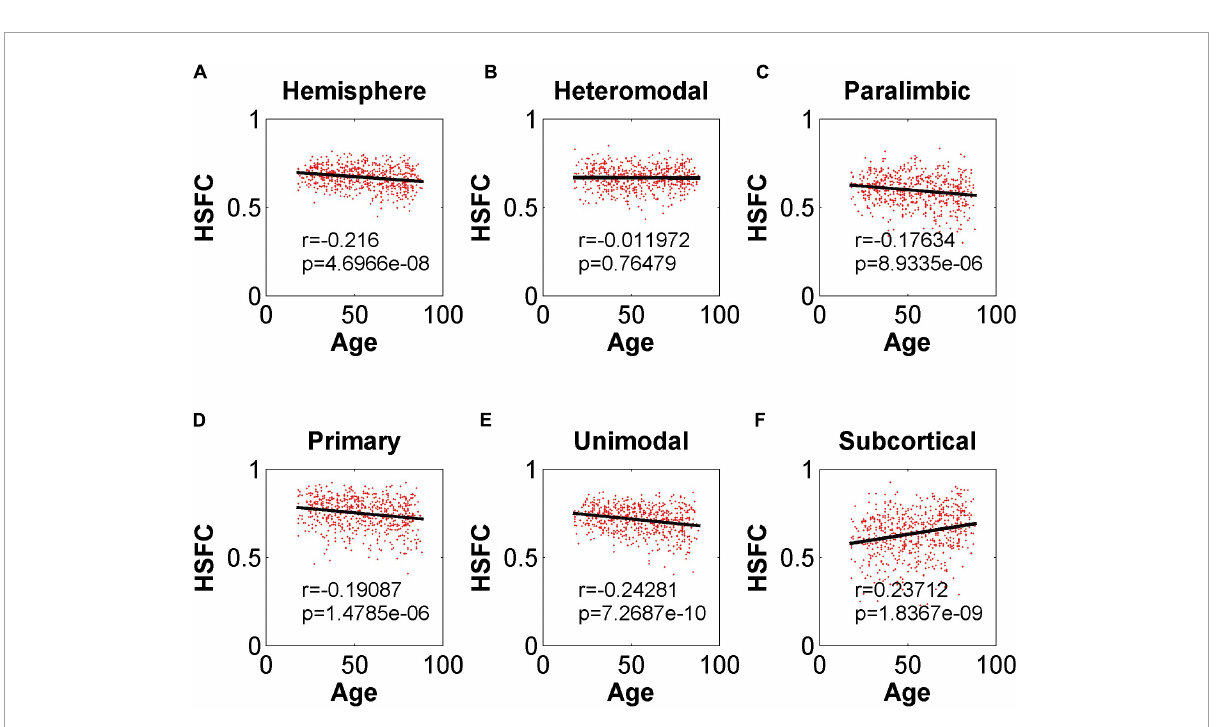
FIGURE10 Pearson correlation between age and HSFC of hemisphere and five sub-modules for AICHA template with NGSR. (A–F) Represent the hemisphere, heteromodal, paralimbic, primary, unimodal, subcortical,